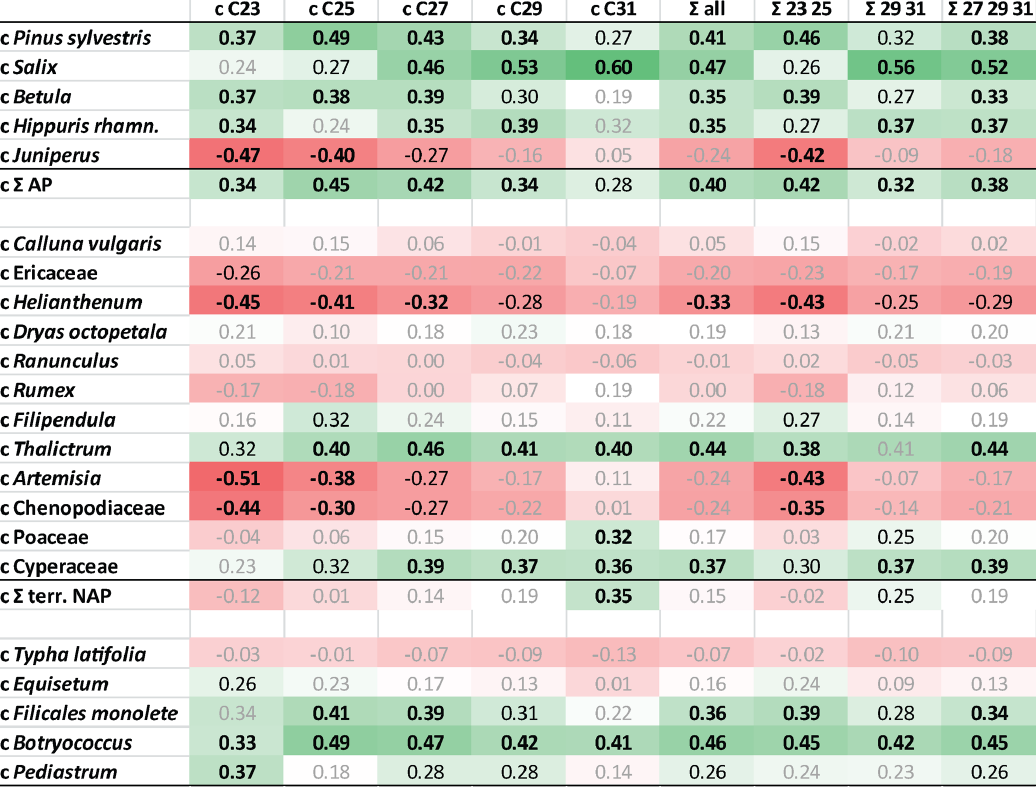
Figure 5. Heat map table illustrating Pearson correlation coefficients between concentrations of pollen and n -alkanes at the Allerød–YD transition (1230–1271cm). Data have been z -transformed before correlation. Bold black numbers: p< 0 . 01. Black numbers: p< 0 . 05. Positive correlations in green and negative correlations in red. AP: arboreal pollen. NAP: terrestrial non-arboreal